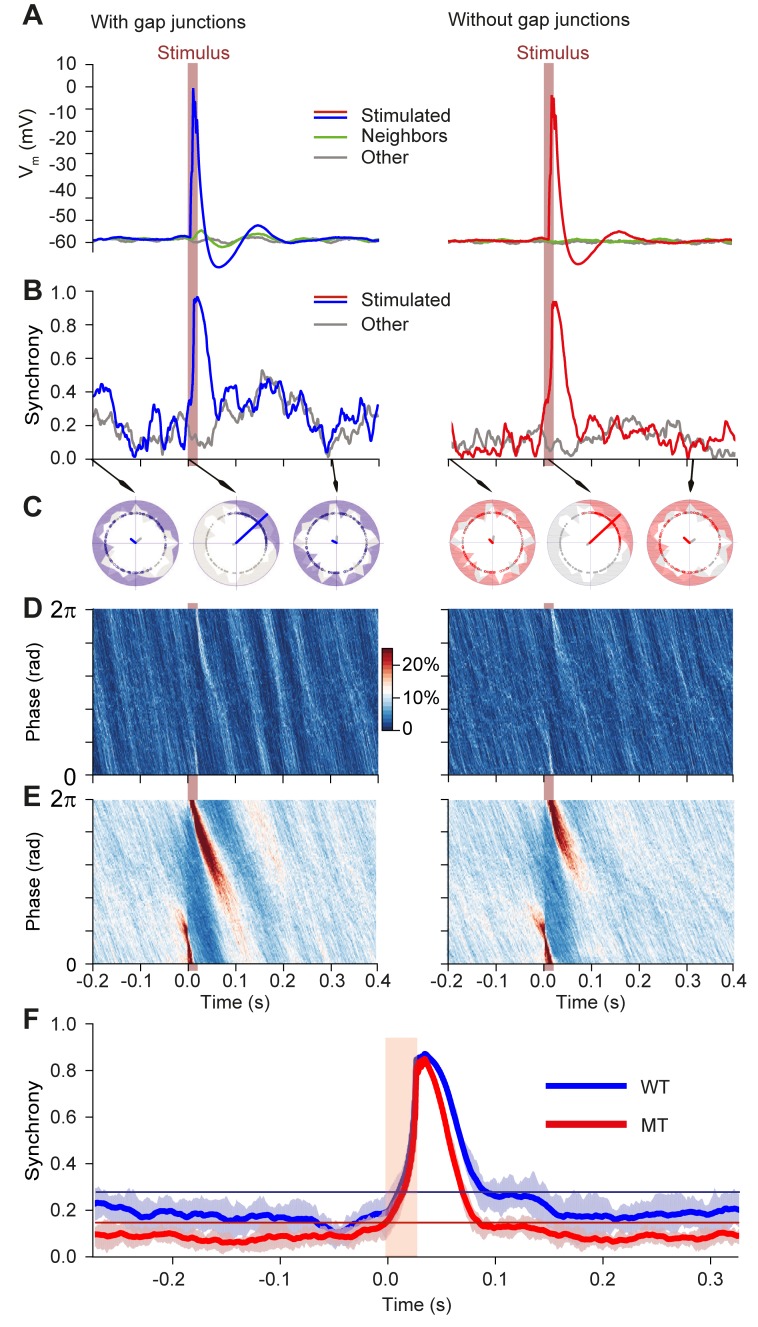
Gap junctions reinforce synchronous behavior after sensory stimulation.Impact of periodic stimulation on network phase in the presence of contextual stimuli for networks with (left column) and without gap junctions (right column). Brown bars indicate stimulation time. (A) Stimulus triggered membrane potential for all cells in the network (n = 100 stimuli). Stimulation causes a peak in the membrane potential of the directly stimulated cells (red line; cf. mask in Fig 5A). The effect of the current spreading through gap junctions is visible in the cells immediately neighboring the stimulated cells (green line), whereas it is absent in the network model without gap junctions. (B) Increase of synchrony in the network due to a single stimulus. Synchrony is displayed as phase concentration over time (the Kuramoto parameter) for cells under the stimulation mask (colored) and other cells (gray). Stimulation generated a similar synchrony peak in both networks, but the transient synchrony after the peak is considerably higher and longer lived in the network with gap junctions. (C) Polar plots indicating network phase distribution for snapshots (arrows) for stimulated (colored distribution) and non-stimulated cells (gray distribution). Phase alignment of subthreshold oscillations of the inferior olivary network model was reduced in the absence of gap junctions. The lines in the middle of the plots indicate average phases for either the stimulated cells (in color) or all cells (gray). (D) Phase distribution of cells over time. Color code represents the proportion of neurons occupying a certain phase at a given time (phase bin size 2π/100, time bin is 1 ms). Dark/light bands indicate that the phase alignment propagates to most cells in the network and subsists for longer durations for the WT network. Nevertheless, contextual input overruled the phase alignment within a few hundred milliseconds (~300 ms in this case). In the absence of gap junctions, the impact of the stimulus is restricted to stimulated cells, so that the coherence induced by stimulus on the network was much smaller. (E) Same as in D but displaying averaged phase distributions for 100 stimuli. The stimulus hardly evoked an effect after 200 ms, and it did not induce any entrainment, which would have been visible as vertical bands before the stimulus. The effect of the stimulus is not stereotypical, due to dependency on network state driven by contextual input (see also Fig 9). (F) Average network synchrony triggered on the stimulus. The horizontal lines in the bottom plot are the 95% inclusion boundaries taken from the 5 s of spontaneous network behavior to contextual input (no periodic “sensory” pulses). The model network with gap junctions displayed after the early stimulus response curve an elevated synchrony plateau, which ended after about 200 ms, whereas the model without gap junctions hardly showed any secondary plateau. There was no preceding synchrony, indicating complete absence of entrainment to the periodic stimulus.